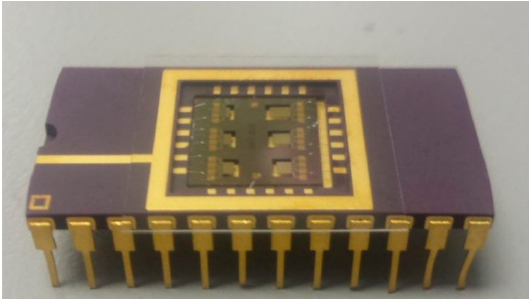
Figure 3. Photograph of a sensor die containing six cantilever resonators. The die was glued and bonded inside the cavity of the package, which was filled with liquid and covered with a thin glass for the experiments.